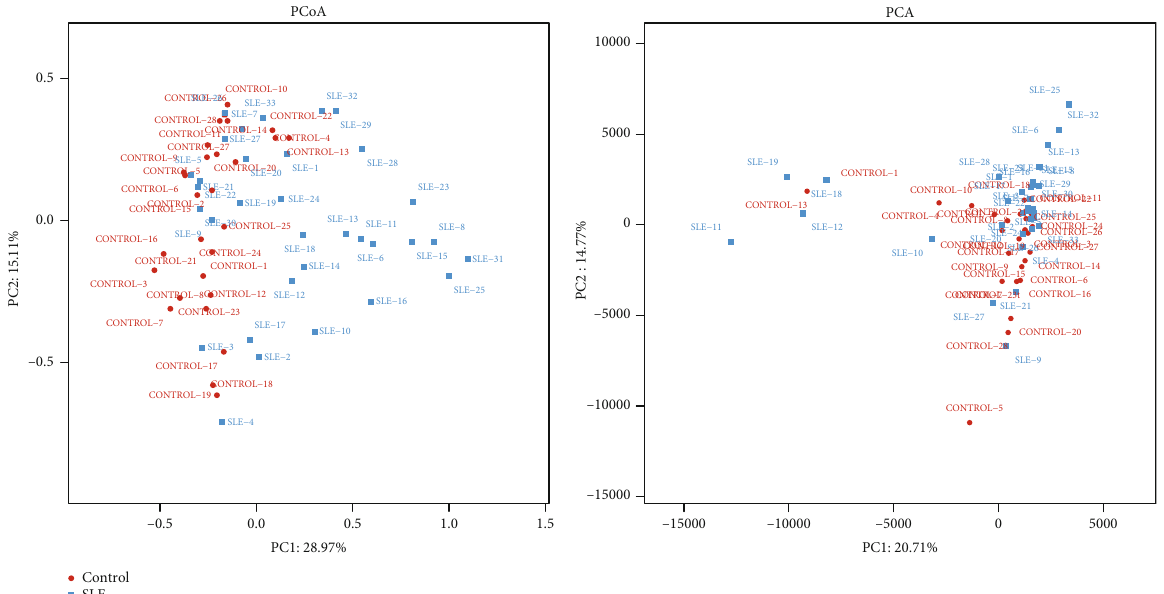
Figure 2: PCoA analysis and PCA analysis were conducted by R version 3.5.1. The red dots represent health controls, and the blue dots represent systemic lupus erythematosus patient samples. PCoA analysis sorts a series of eigenvalues and eigenvectors. It selects the most important eigenvalues ranked in the fi rst few and shows them in the coordinate system. The result can be regarded as a rotation of the distance matrix. The red dots and the blue dots distribute in di ff erent clusters on the coordinate axis, revealing a clear separation between the SLE and HC groups. PCA analysis uses variance decomposition to re fl ect the di ff erences of multiple groups of data on the two- dimensional coordinate graph. The PCA analysis of our study did not show clear